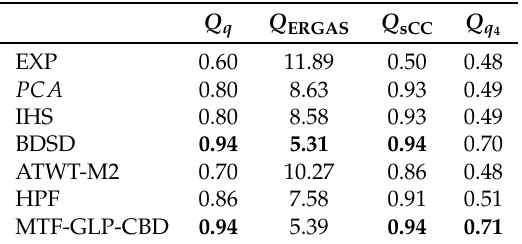
Table 5. IKONOS Roma Urban scene, reduced resolution metrics quantitative results. The bold number indicates the best performing PS method according to each quality metric.